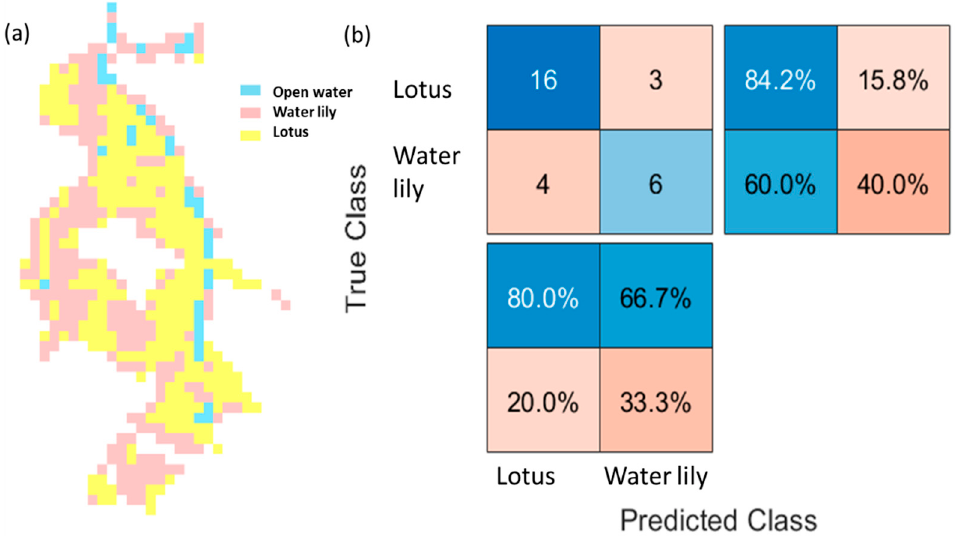
Figure 6. ( a ) HLS classification result of 2020. ( b ) A confusion matrix comparing the result with field survey points.